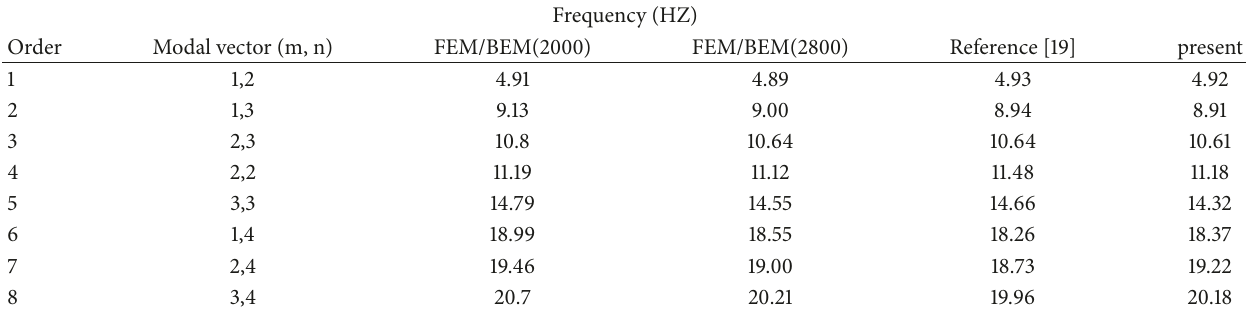
Figure 3: Power transmitted by different shell forces (moments) for shell filled and unfilled with water: (a) 𝑛 = 0 , Ω = 0.3 ; (b) 𝑛 = 0 , Ω = 1.2 ; (c) 𝑛 = 0 , Ω = 3.0 ; (d) 𝑛 = 1 , Ω = 0.3 ; (e) 𝑛 = 1 , Ω = 1.2 ; (f) 𝑛 = 1 , Ω = 3.0 ; black solid line: 𝑃 󸀠 𝑆(𝑥) ; blue dashed double dotted line: 𝑃 󸀠 𝑇(𝑥) ; red dashed line: 𝑃 󸀠 𝑆(𝑥) ; green dashed dotted line: 𝑃 󸀠 𝑀(𝑥) . Table 2: Comparison of frequency for a C-C cylindrical shell ( L =20 m, R =1 m, and h =0.01 m). Frequency